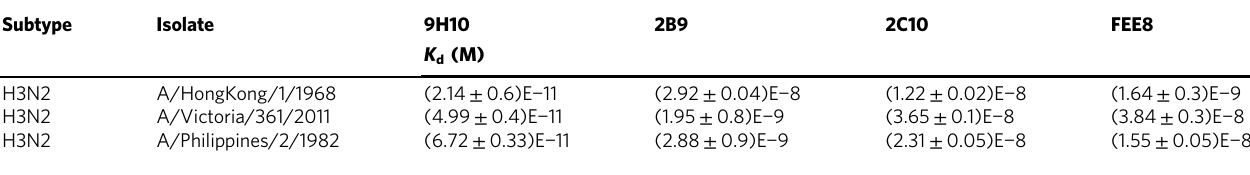
Table 1 Af fi nity measurements of monoclonal antibodies by biolayer interferometry